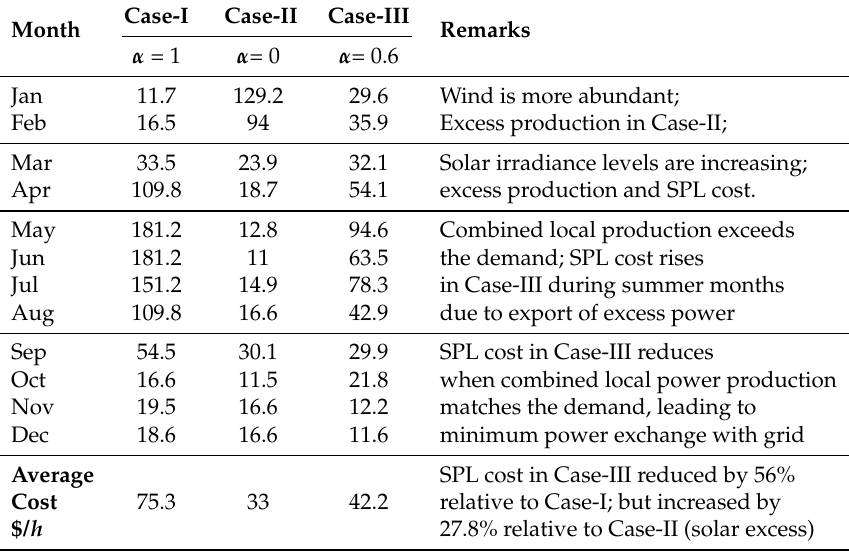
Table 4. Breakdown of the SPL cost ($/h) at Location C for different months of the